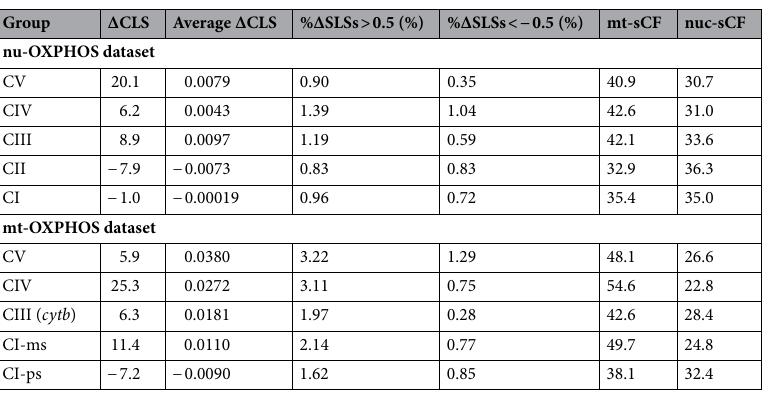
Table 2. The phylogenetic signal of nu and mt-OXPHOS markers grouped by complexes. The CI mt-markers are split into two groups: CI-ms is comprised by nadh1,2,6 and CI-ps is comprised by nadh3,4,4l,5. For each